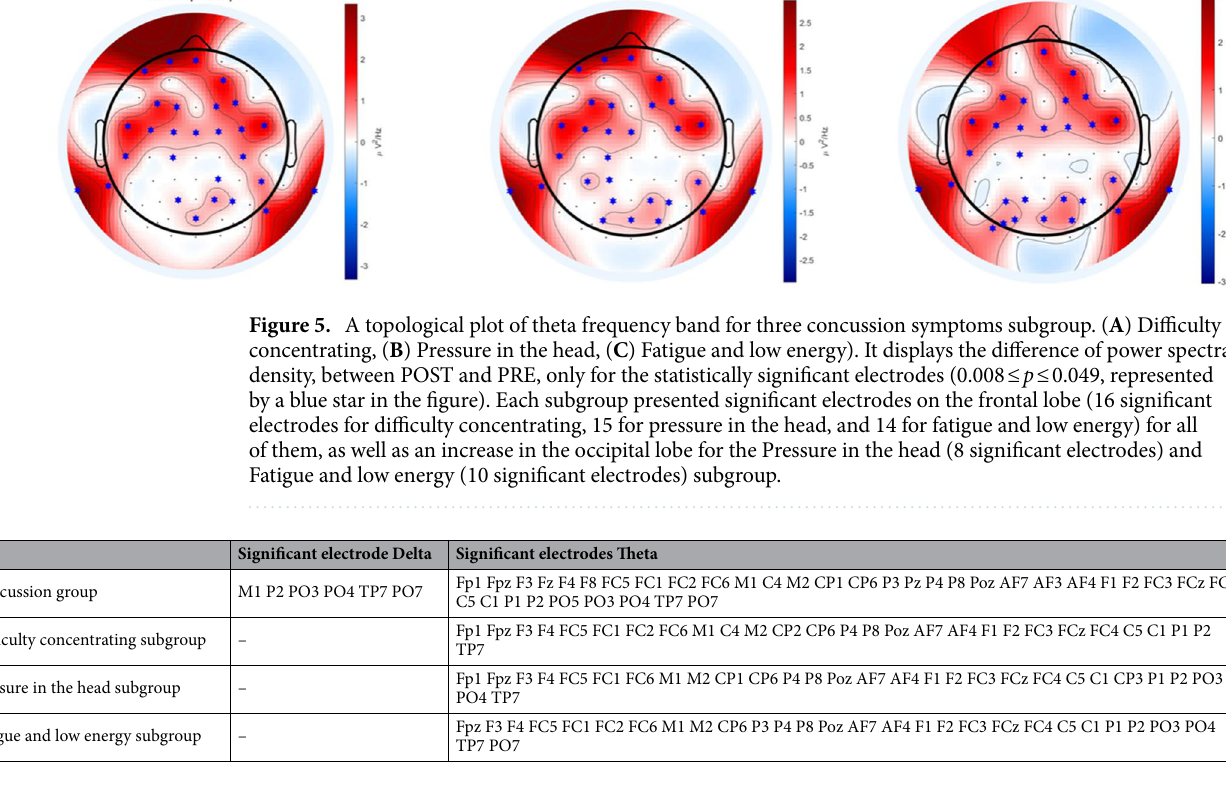
Table 3. – Significant electrodes of delta and theta band for the concussion group and